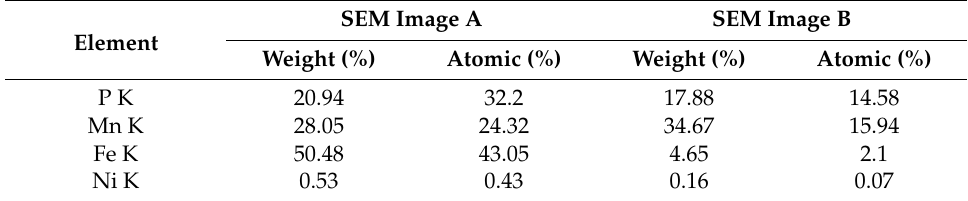
Table 7. The chemical composition for samples A (Mn_0) and B (Mn_2.0) based on EDX